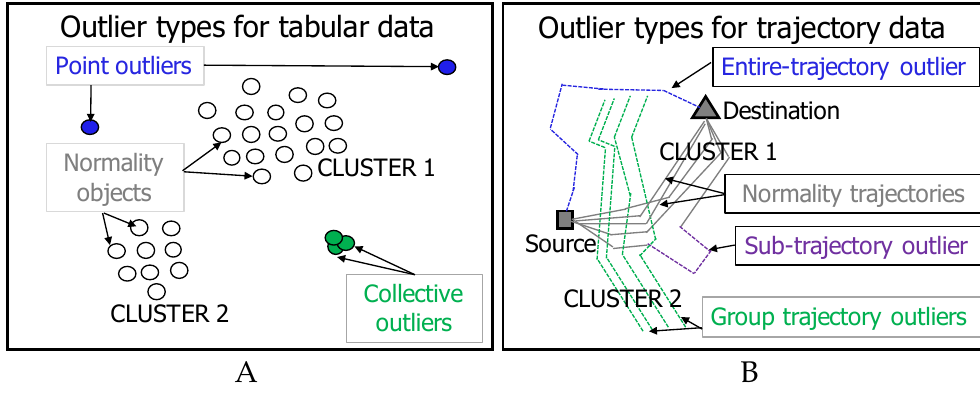
Figure 1. Outlier types. ( A ) tabular data: point and collective outliers; ( B ) trajectory data: sub-, entire-, and group-trajectory